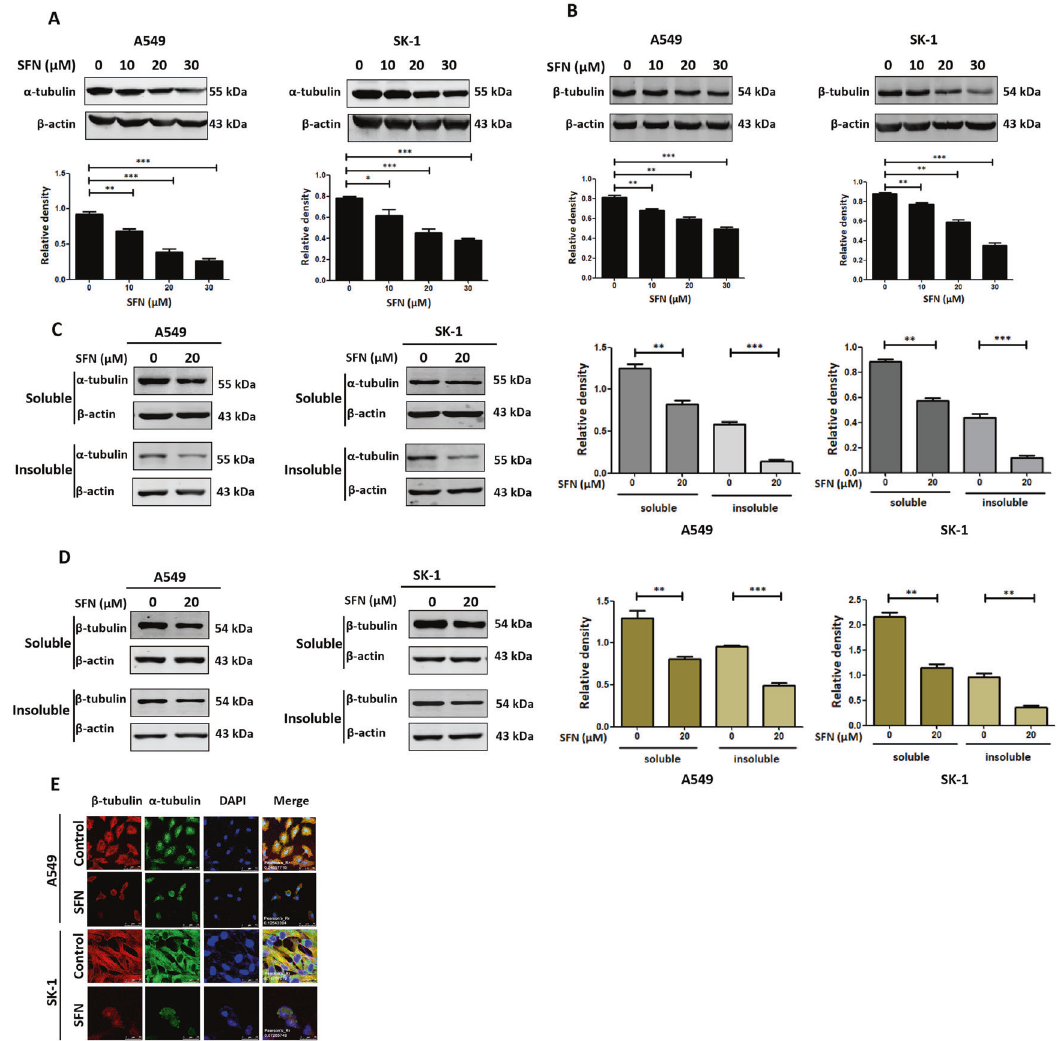
Fig. 2 SFN caused microtubule disruption by breaking α -tubulin and β -tubulin dimer. A , B The accumulation of α -tubulin and β -tubulin was detected by western blotting after the treatment of 0, 10, 20, and 30 μ M SFN for 24 h in A549 and SK-1 cells. C , D Both A549 and SK-1 cells were treated with/without 20 μ M SFN for 24 h. Then the accumulation of soluble and insoluble α -tubulin ( C ) or β -tubulin ( D ) was determined by western blotting in both A549 and SK-1 cells. E Immuno fl uorescence and confocal microscopy were employed to view the colocalization of α -tubulin to β -tubulin. Scale bar: A549: 75 µm, SK-1: 25 µm. Data were shown as means ± SEM ( n ≥ 3). ** P ≤ 0.001; *** P ≤